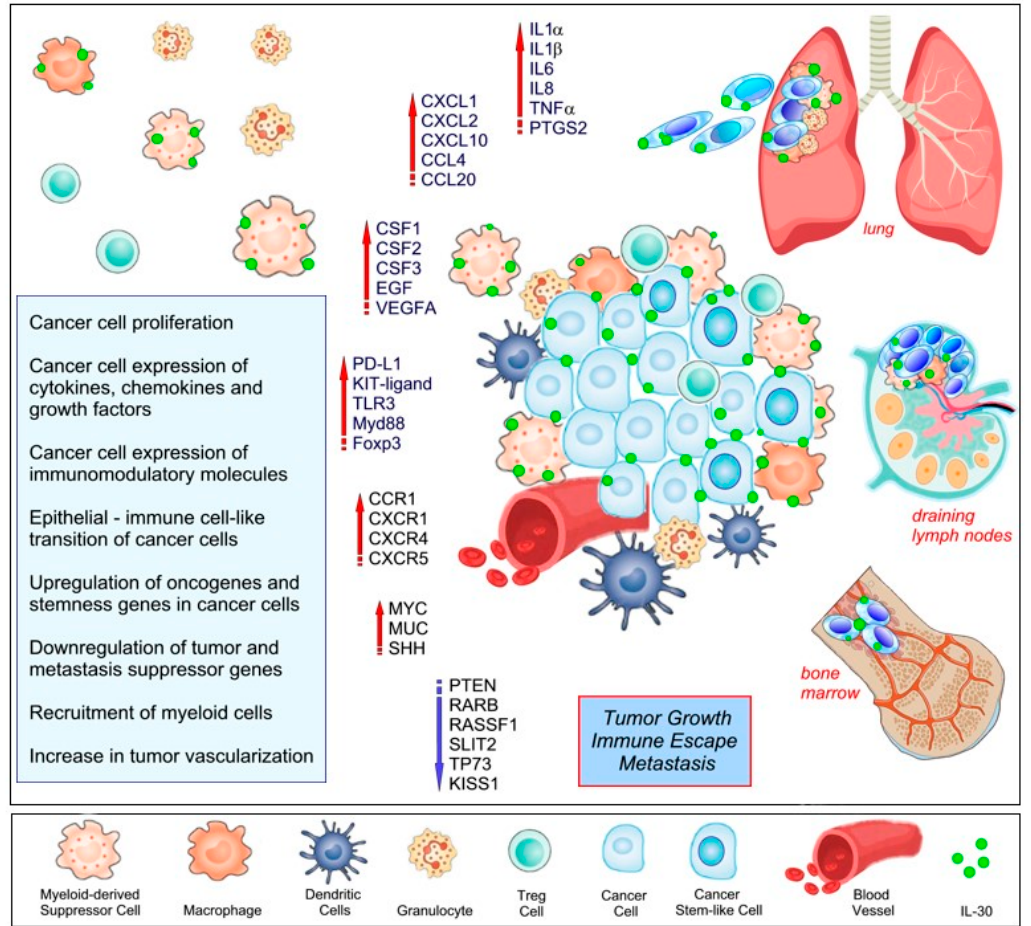
Figure 3. Effects of IL-30 expression by cancer and myeloid cells in the tumor microenvironment. On the left side, the effects of IL-30 on cancer cells and on the composition of immune cells infiltrating the tumor are listed. On the right side, the effects of IL-30 on tumor behavior are represented.